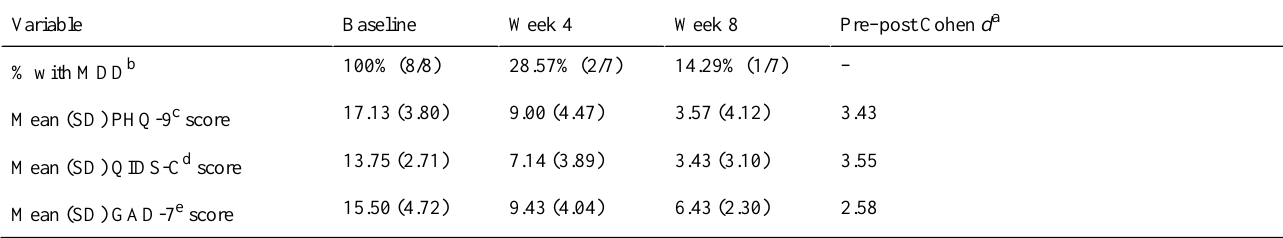
Table 2. Per-protocol clinical outcomes